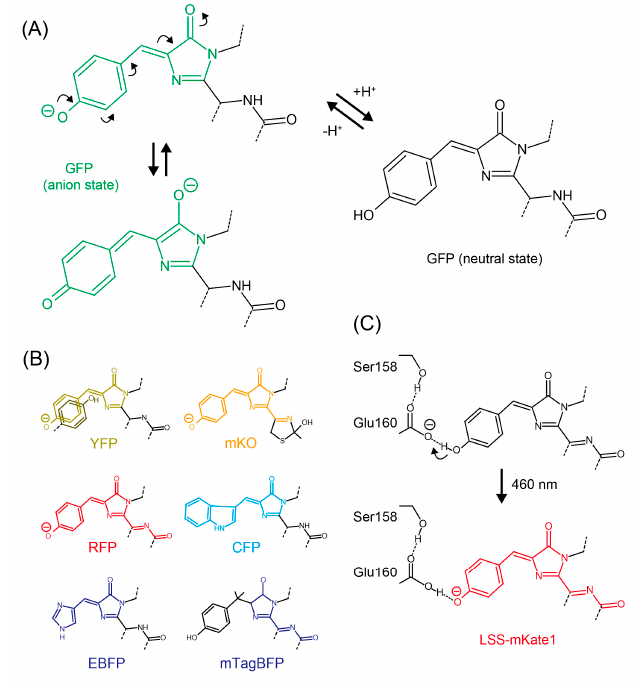
Figure 1. Chromophore structures of GFP-like proteins. ( A ) Protonation of the GFP chromophore